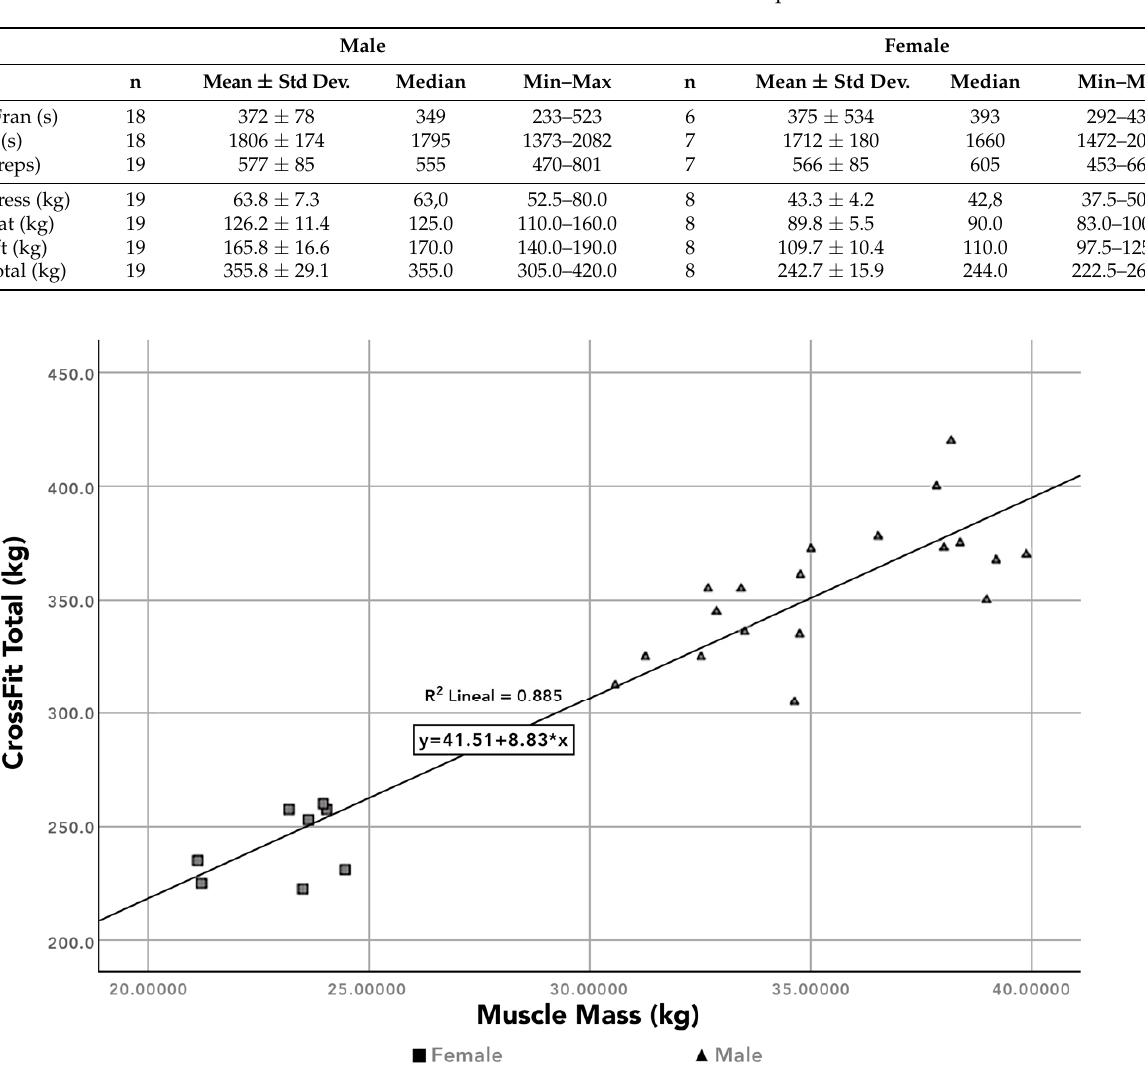
Table 2. Results of the WODs for the selection of the sample.